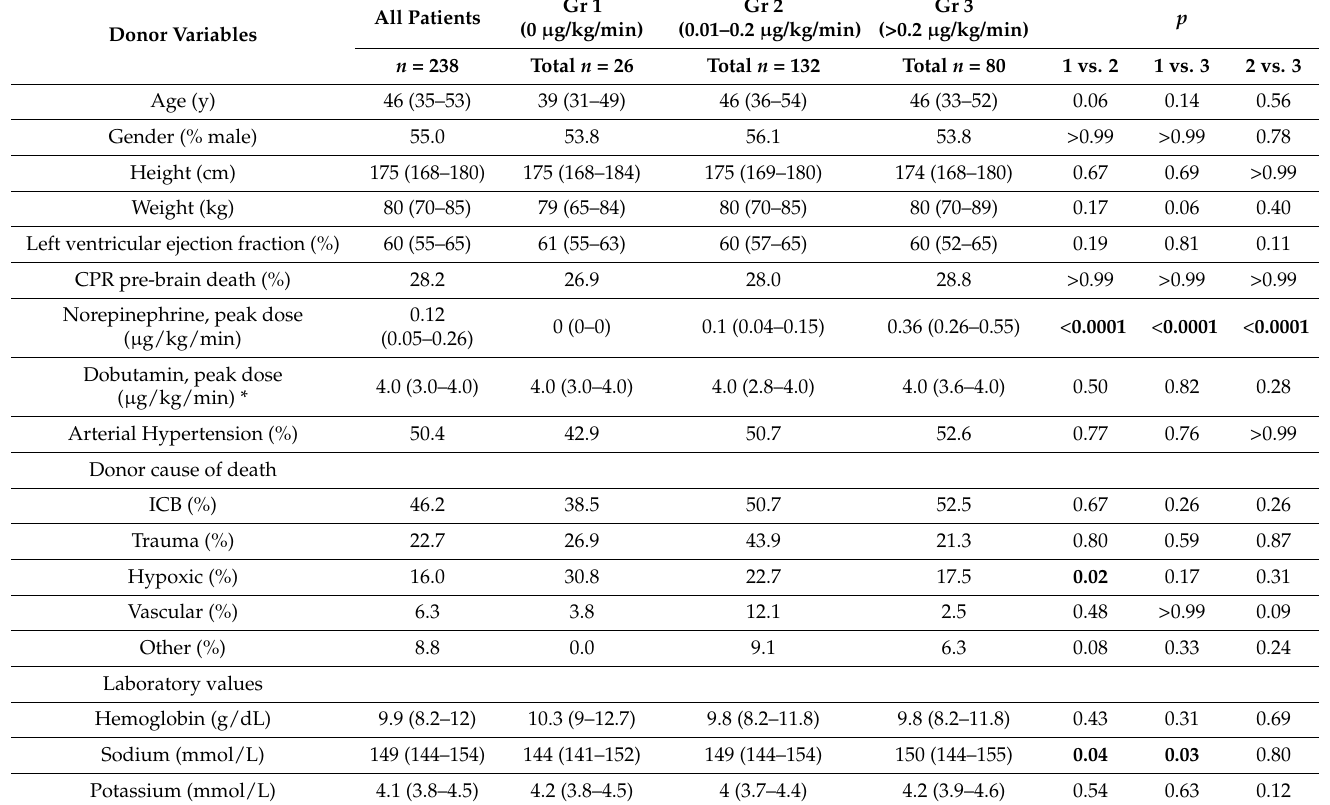
Table 2. Preoperative donor parameters. Preoperative donor data regarding the donor noradrenaline support: No (0 µ g/kg/min, n = 26), medium (0.01–0.2 µ g/kg/min, n = 132) or high (>0.2 µ g/kg/min, n = 80). Shown are median values with interquartile range (Q1–Q3) for continuous variables or percentages for discrete variables. Significance was calculated using the Pearson chi-square test or, if its conditions of application were not met, the Fisher exact test for qualitative variables and the t -test for quantitative variables. Bold p -values stand for statistical